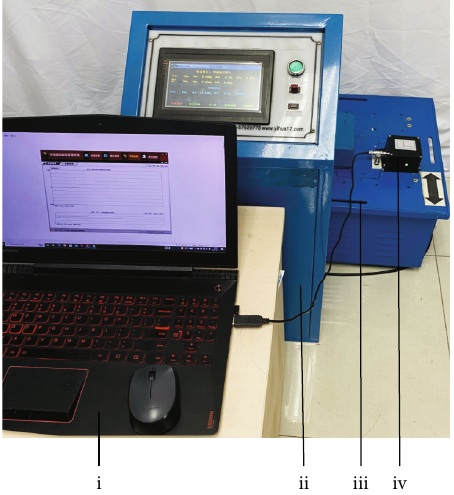
Figure 7: Function and performance test picture. (a) PC monitoring. (b) Vibration test console. (c) Vibration test platform. (d) Shock and vibration acceleration